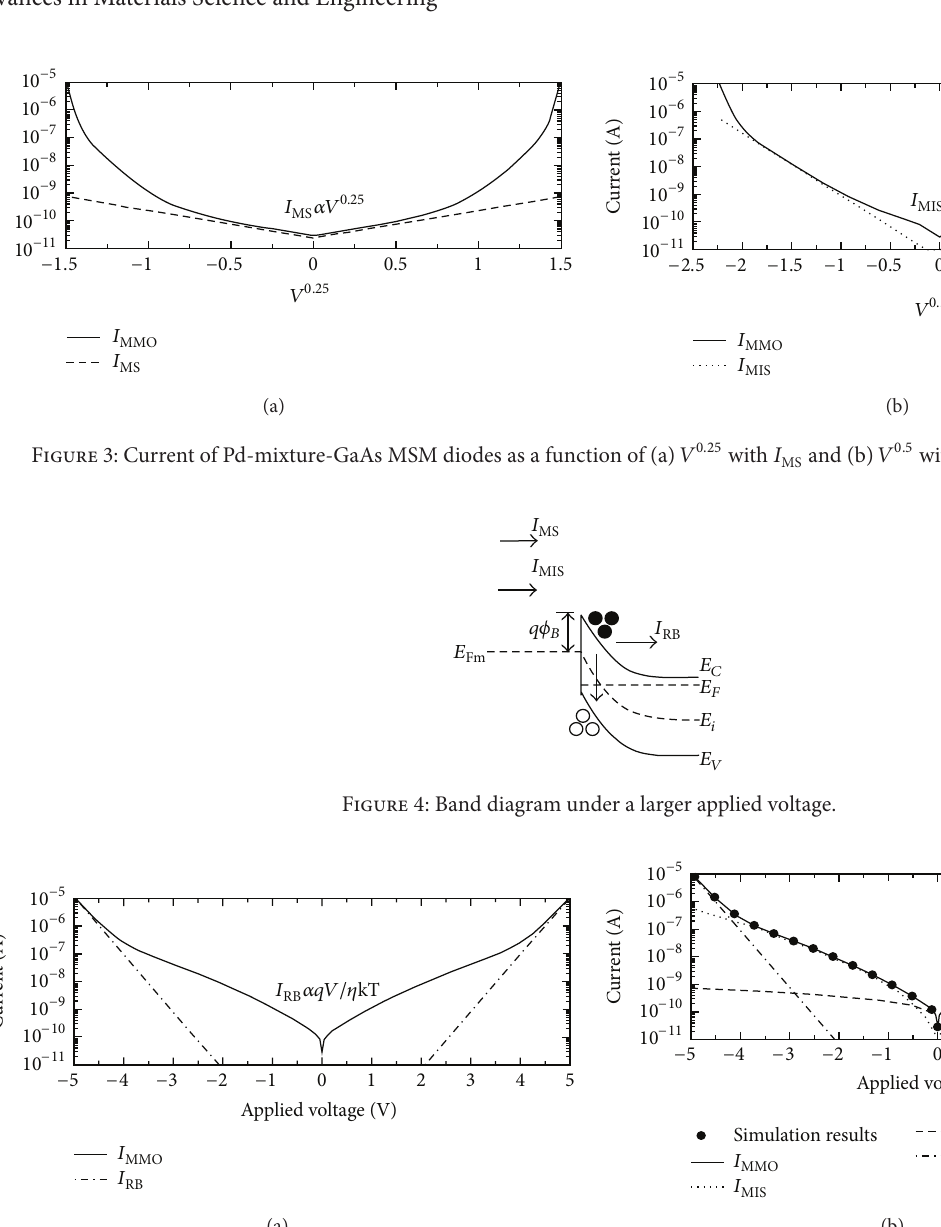
Figure 5: Current as a function of applied voltage for Pd-mixture-GaAs MSM diodes with (a) 𝐼